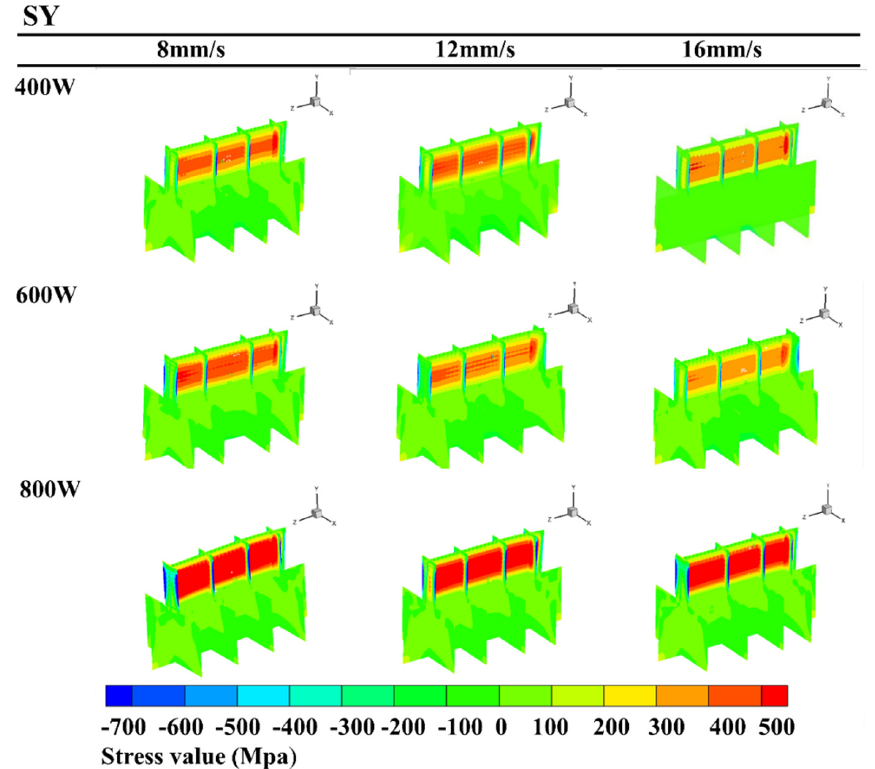
Figure 7. The YY stress distributions under different scanning speed and laser power values when the layer thickness is 0.4 mm.